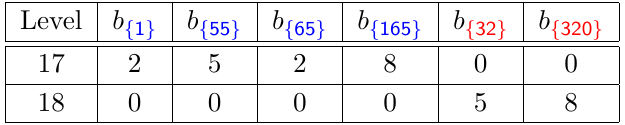
Table 6. Summary of important component (cid:12)elds contained in the super(cid:12)eld (cid:9) (cid:11) .